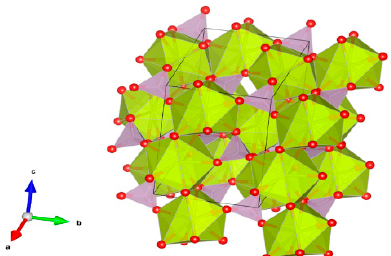
/ n. Cations can be Li,